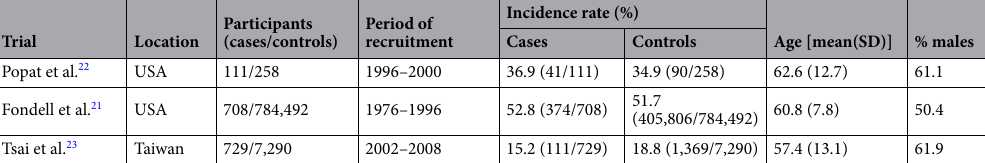
Table 2. Characteristics of case control trials assessing aspirin use and incidence of ALS in the systematic review.